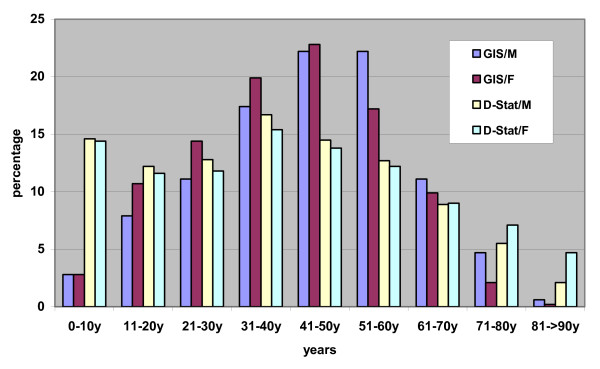
Age distribution of the Male (M) and Female (F) GIS population and the Dutch (D-Stat) population.